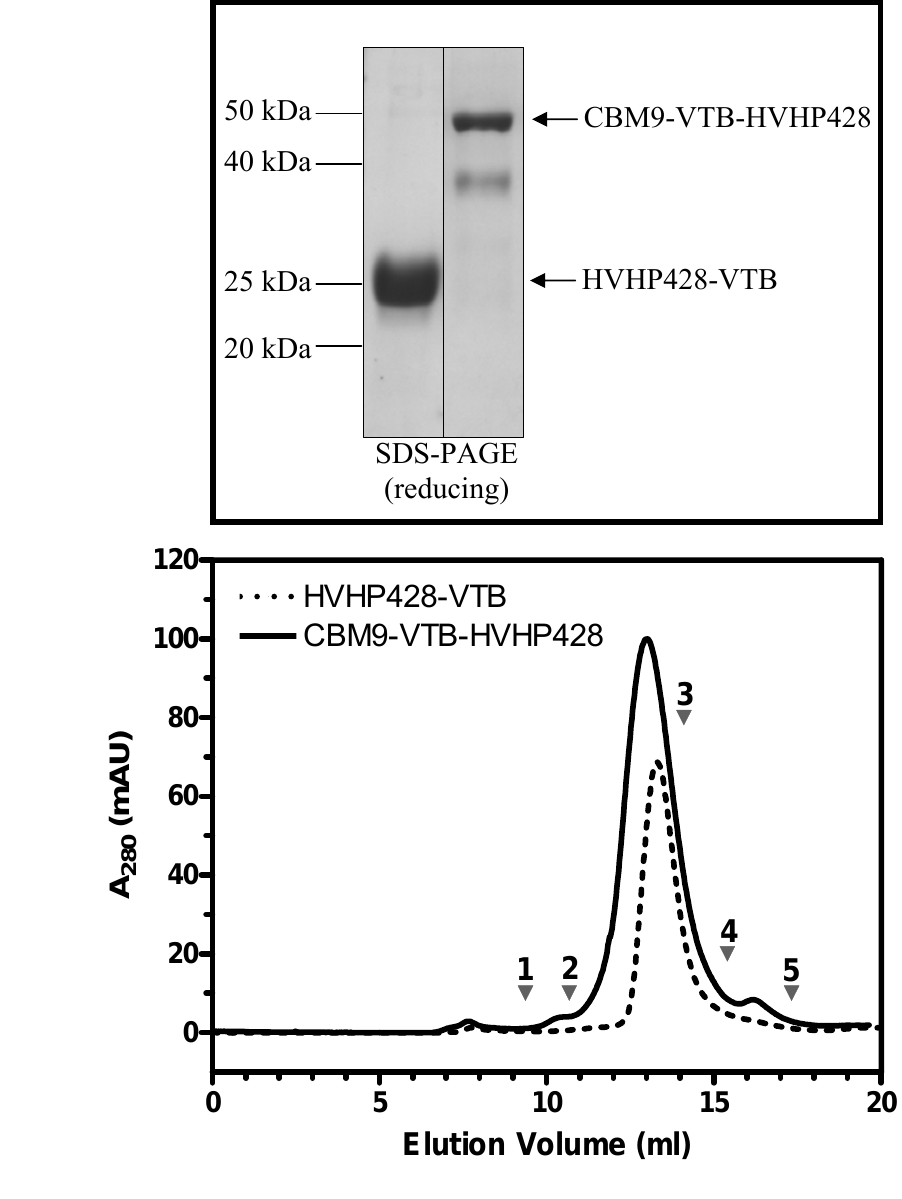
Figure 3. Analysis of purified monospecific and bispecific pentamers. (A) SDS-PAGE (reducing conditions, ~3 µg protein per lane) demonstrating the stability of purified proteins which had been stored at 4 ºC for six months. The reducing conditions separated the pentamerized molecules into five single polypeptide chains. The expected masses of monospecific HVHP428-VTB and bispecific CBM9-VTB-HVHP428 in an SDS-PAGE gel are 24.4 kDa and 45.7 kDa, respectively. (B) Size exclusion chromatography using a Superdex 200™ column revealed both HVHP428-VTB and CBM9-VTB-HVHP428 were non-aggregating since a single, homogeneous peak was observed for each within the expected mass range. The bispecific CBM9-VTB-HVHP428 pentamer eluted later than 669,000); expected. Protein standards are indicated with arrows. 1: thyroglobulin (M r 2: ferritin (M 440,000); 3: BSA (M 67,000); 4: beta-lactoglobulin (M 35,000); r r r 5: ribonuclease A (M r